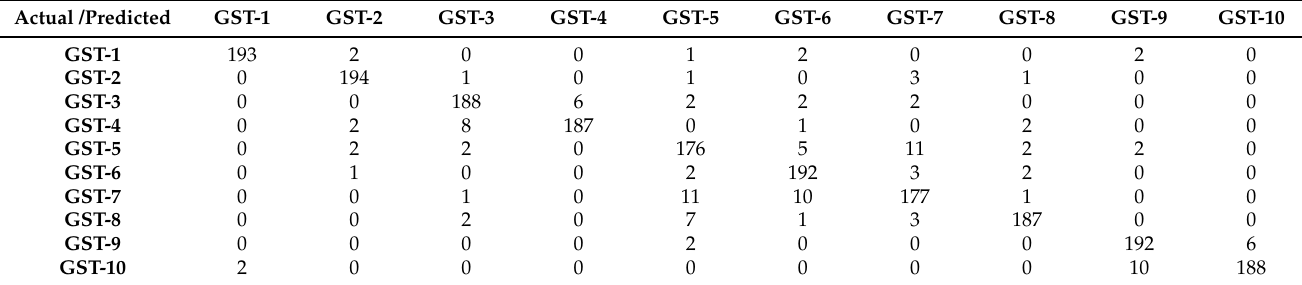
Figure 5. The KNN algorithm accuracy using different K-values and distance measures. Table 5. Confusion matrix for KNN classifier using Manhattan distance with the cross-validation factor of